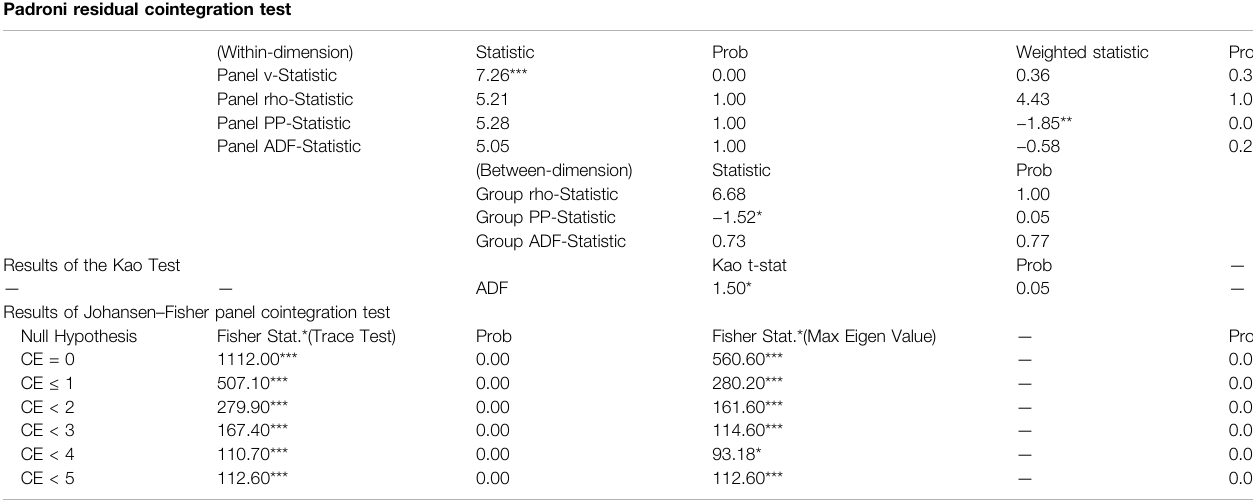
TABLE 5 | Results of the Padroni, Keo, and Fisher cointegration test. Padroni residual cointegration test